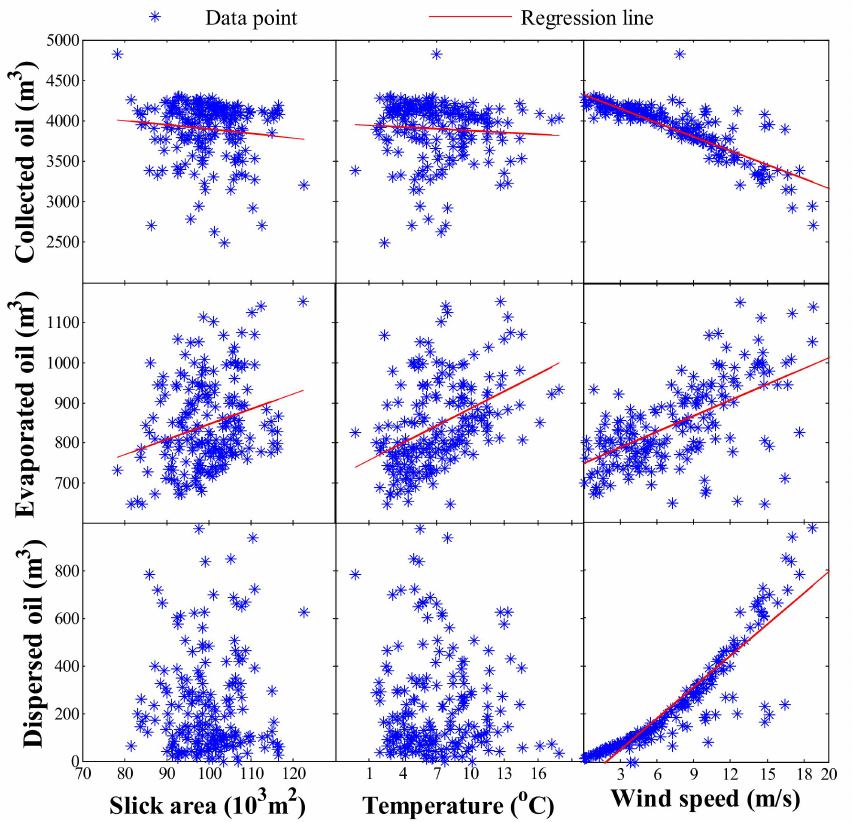
Figure 16. Correlations between oil budgets (collection, evaporation and dispersion) and uncertain parameters (slick area, seawater temperature and wind